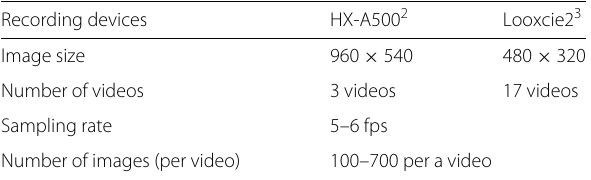
Table 3 Summary of our dataset used for evaluation Table 4 Summary of public dataset used for evaluation